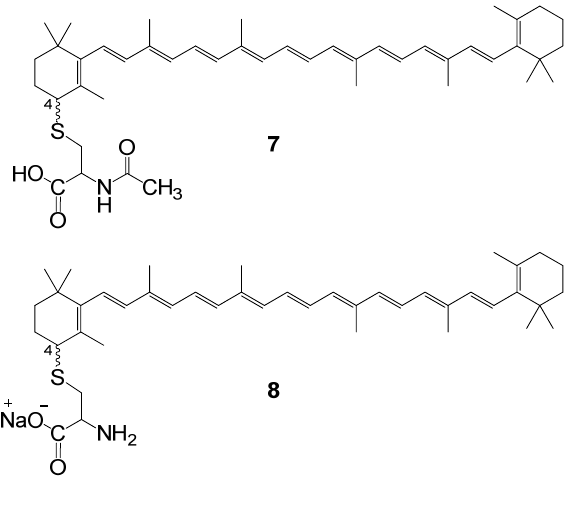
Figure 2. Cysteine conjugates of